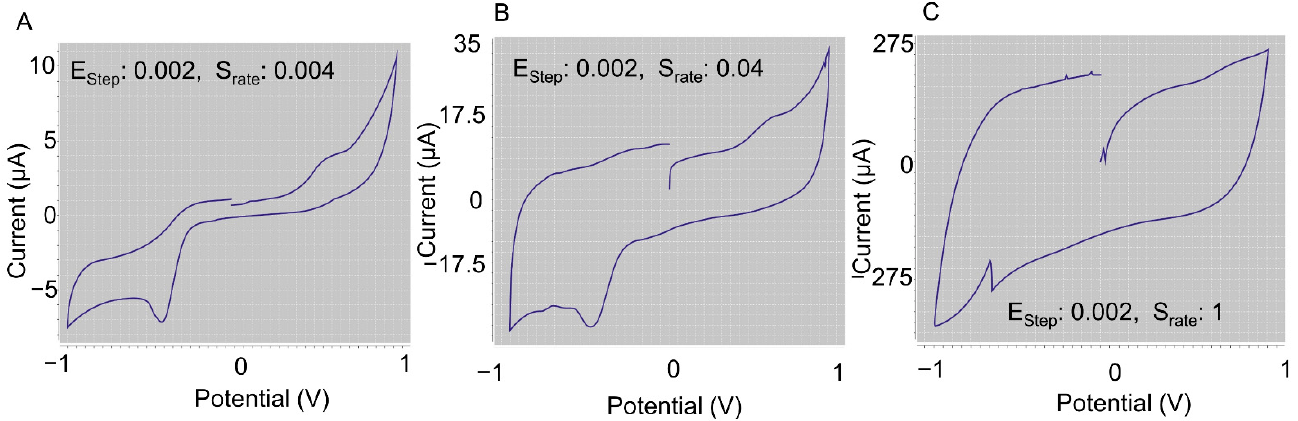
Figure A1. Electrochemical system optimization results for varying S rate . ( A ) E step = 0.002 and S rate = 0.004, ( B ) E step = 0.002 and S rate = 0.04; ( C ) E step = 0.002 and S rate = 1. Second, both E step and S rate values were varied simultaneously from 0.009 V to 0.01 V and from 0.009 V/s to 2 V/s, respectively. Results for specific values are shown in Figure A2.